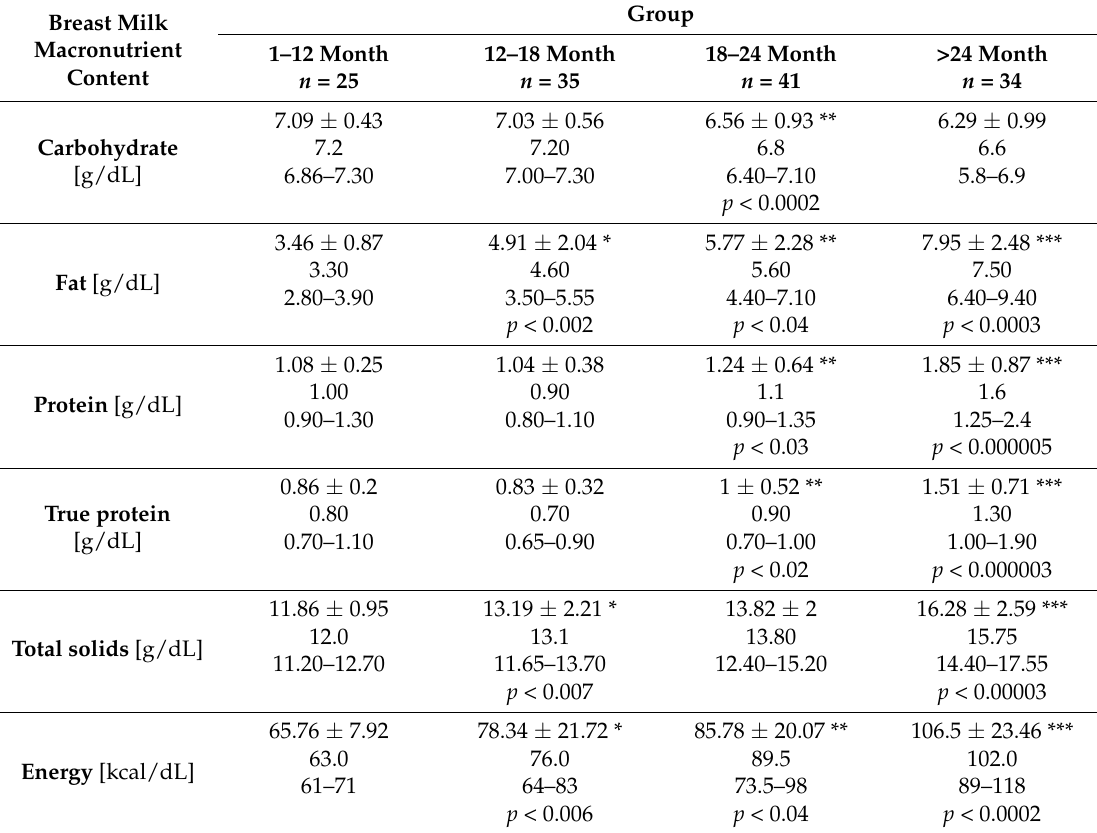
Table 2. Macronutrient and energy content in breast milk in prolonged lactation. Breast Milk